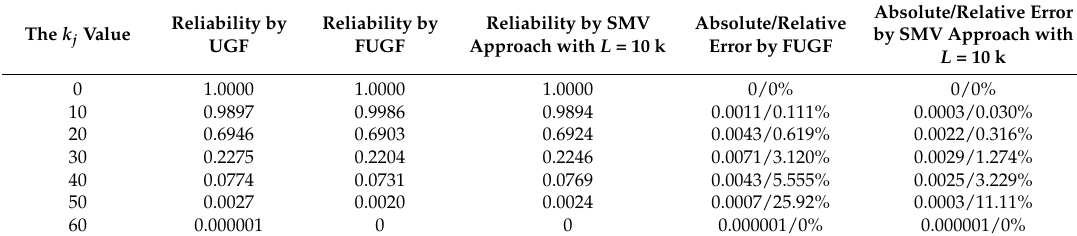
Table 6. Accuracy of the SMV approach and FUGF [19,21], compared with UGF [11,26], when a system of model II has six components with 15 states.